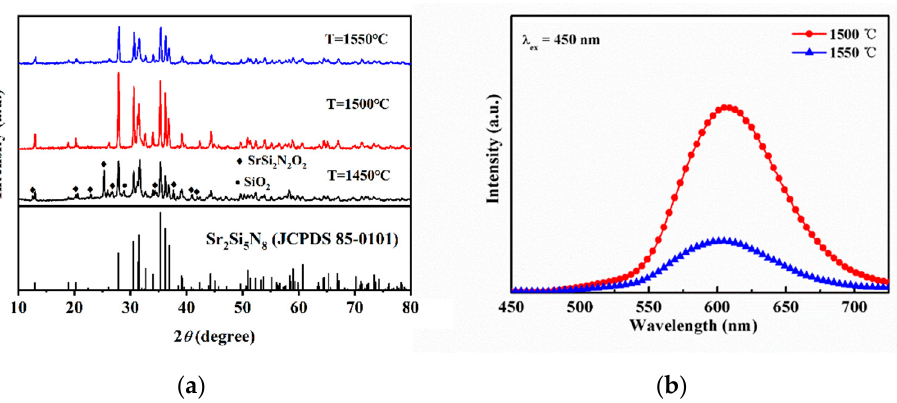
Figure 3. ( a ) XRD patterns and ( b ) emission spectra of Sr 2 Si 5 N 8 : Eu 2+ phosphors with different sintered temperatures.